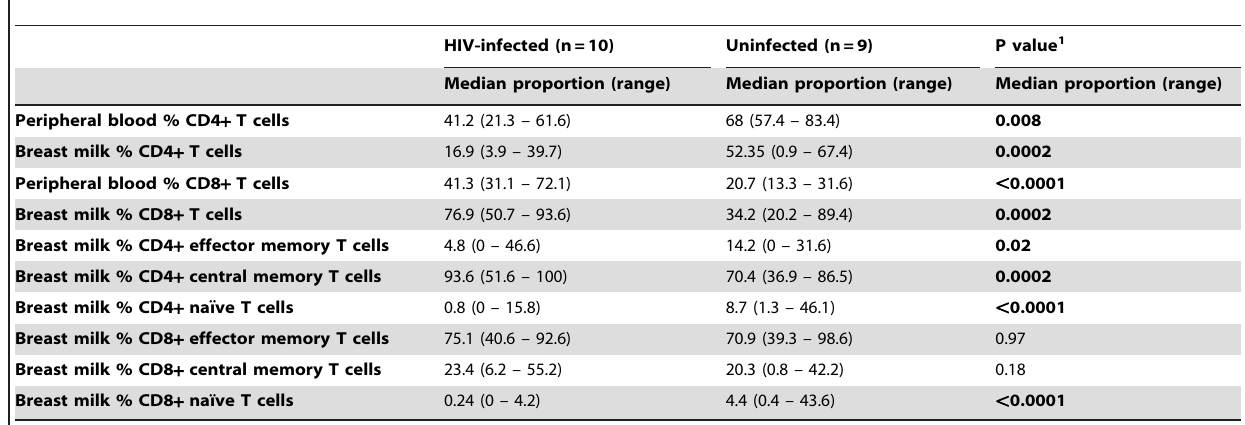
Table 1. The phenotype of CD4 + and CD8 + T lymphocytes in milk of HIV-infected and uninfected Malawian women.